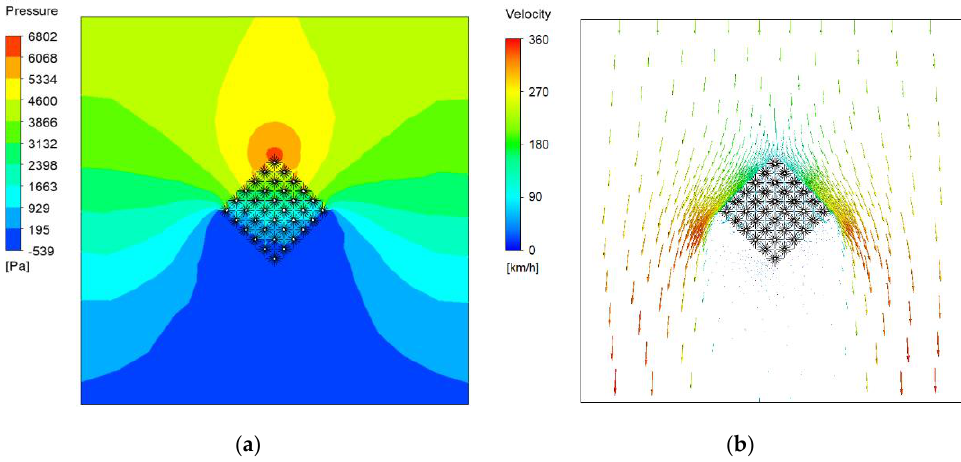
Figure 9. ( a ) Pressure distribution, ( b ) Velocity distribution (s = 200 mm, v inlet = 120 km/h, α = 45 ◦ ).